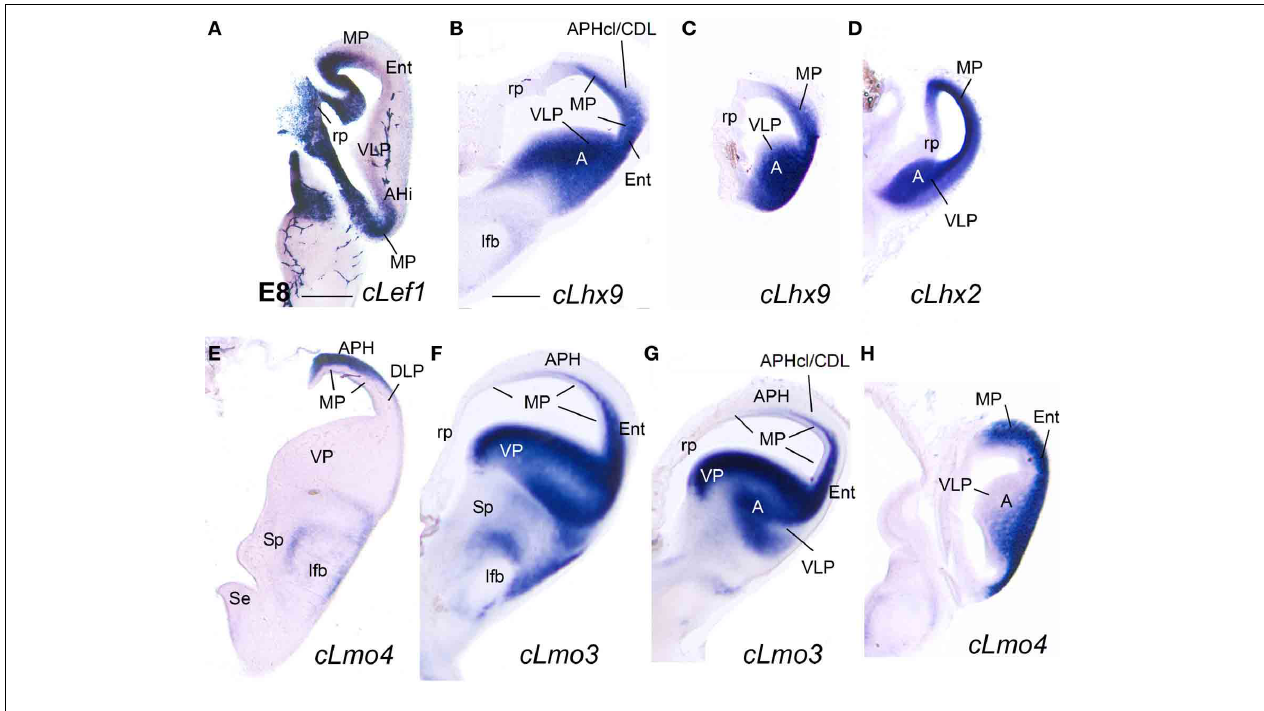
FIGURE 7 | Expression of cLef1, cLhx2, cLhx9, cLmo3 , and cLmo4 in the chicken embryonic telencephalon at early stages. Digital images of coronal sections of chicken embryonic telencephalon (E8), at intermediate (E,F) or caudal (A–D,G,H) levels, hybridized for cLef1, cLhx2, cLhx9, cLmo3,